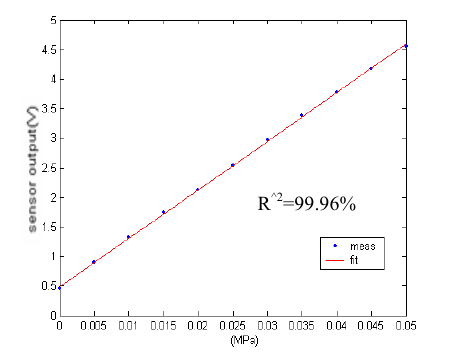
Figure 7. Measured output voltages for different pressures, the ‘goodness of fit’ statistics is 99.96%.